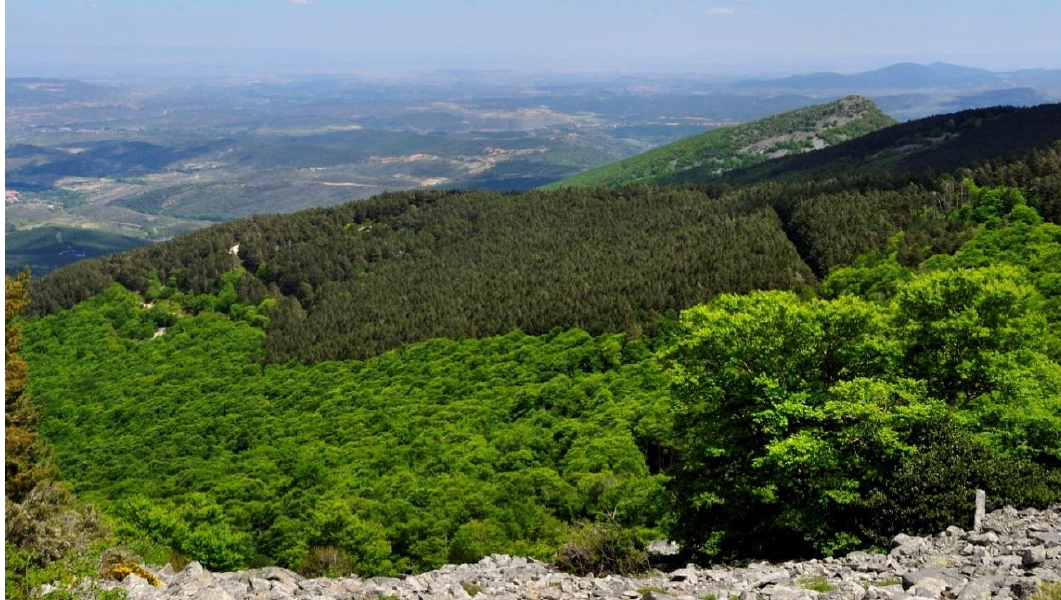
Figure 2. Overview of Moncayo Natural Park showing the two sampled forest types: European beech forest in light green (front) and Scots pine forest in dark green (back).